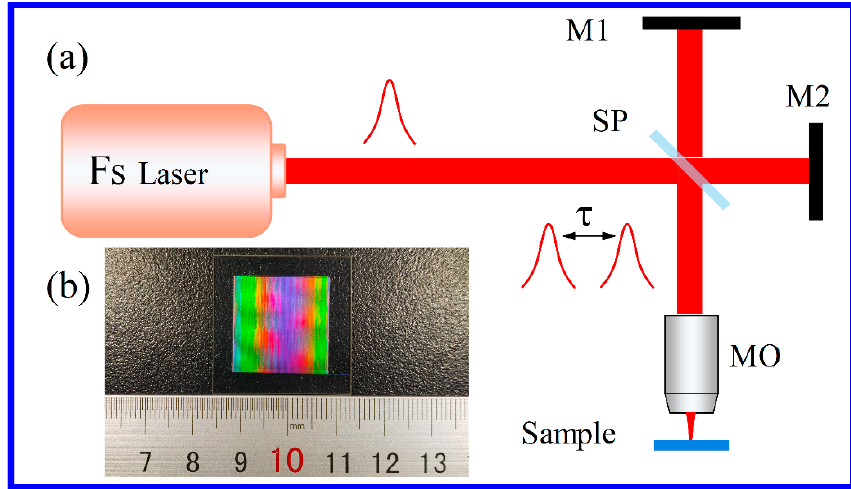
Figure 1. ( a ) Experimental optical system for femtosecond laser double-pulse beam fabrication. Fs: femtosecond, SP: 5/5 spectroscope, M1 and M2: mirror, MO: objective lens, τ : pulse delay. ( b ) Photograph of the laser treated sample.